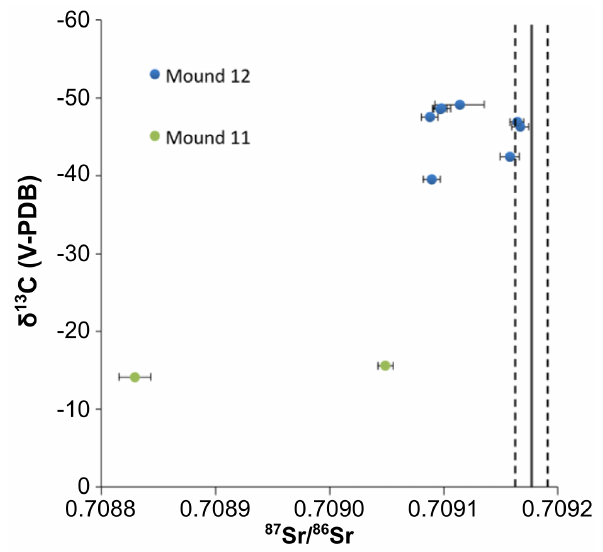
Fig. 6. δ 13 C vs. 87 Sr/ 86 Sr ratios of carbonate material sampled during cruises SO173/4, M66/3a, and M54/3a. Two standard devi- ations (2 σ) of individual 87 Sr/ 86 Sr measurements are given. The solid line indicates the measured 87 Sr/ 86 Sr ratio of IAPSO stan- dard seawater; the dotted lines represent 2 σ . The standard deviation of δ 13 C measurements was 0.02‰ (symbols larger than error